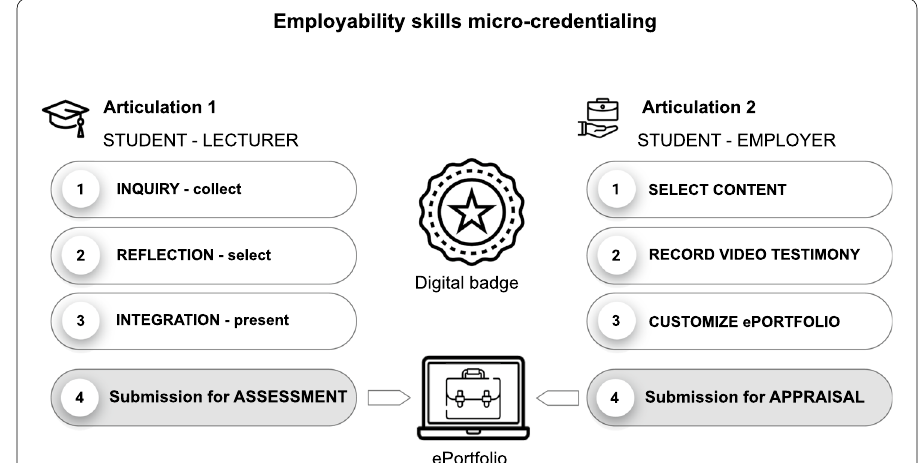
Fig. 1 EPICA methodology—Micro-credential process overview (Source: Authors. EPICA